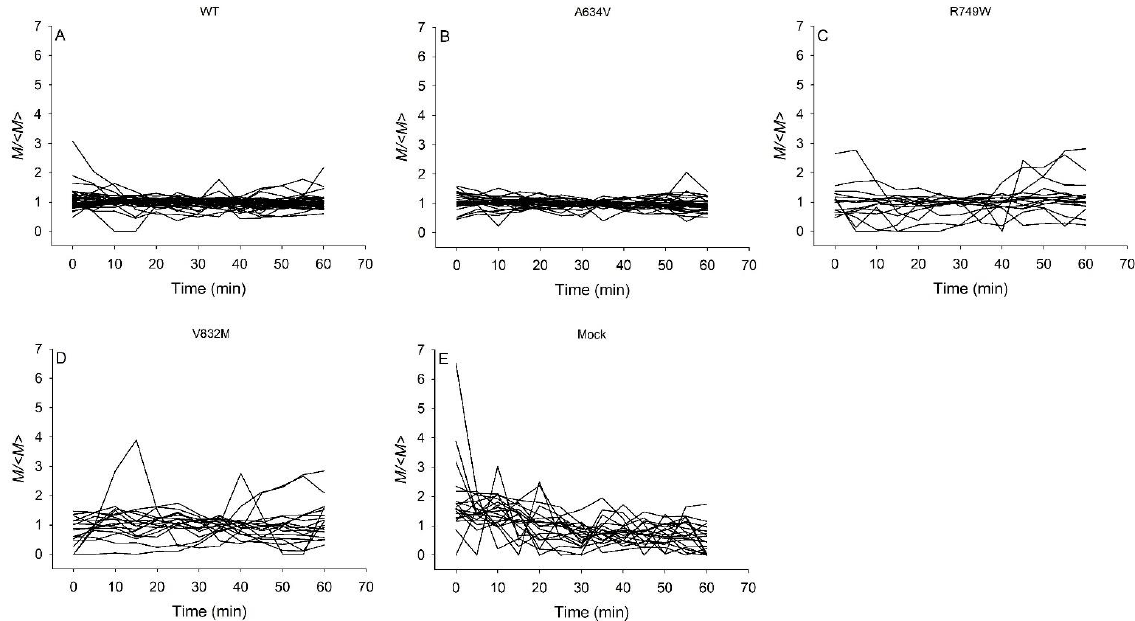
Figure 2. Impact of E-cadherin variants on temporal fluctuations of the contractile moment. Time lapses of normalized contractile moments of different types of AGS cells cultured on the combination of Fibronectin and Vitronectin micropatterns over the course of 60 min experiments. The graphs of WT cells ( A ) and A634V cells ( B ) exhibit smaller temporal fluctuations than the graphs of R749W cells ( C ), V832M cells ( D ), and Mock cells ( E ). Contractile moment ( M ) was normalized by its time-averaged value ( (cid:104) M (cid:105) ). Different lines correspond to different